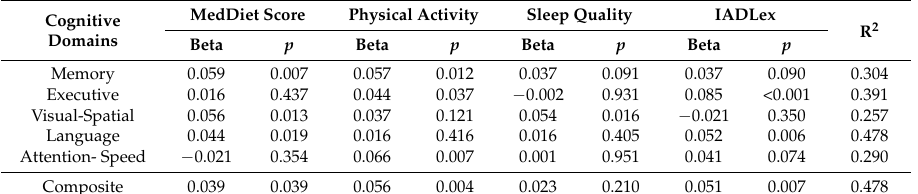
Table 3. Results from multiple linear regression analysis that evaluated the association between lifestyle factors composed TLI (independent variables) and z-scores of cognitive performance (dependent variables) in non-demented